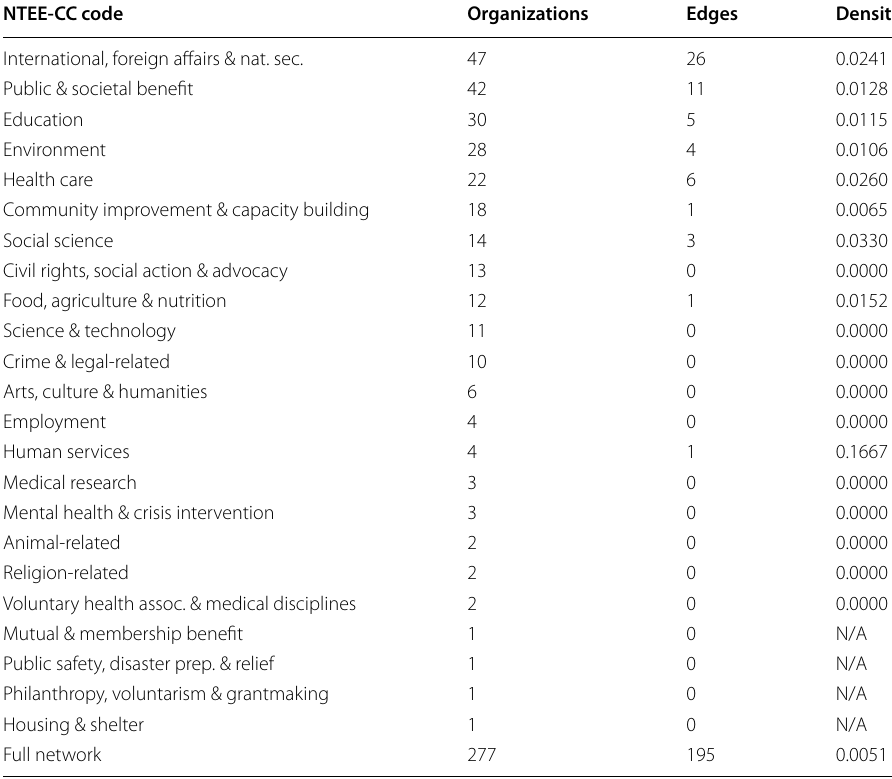
Table 5 Subgraph density by organization NTEE‑CC code NTEE-CC